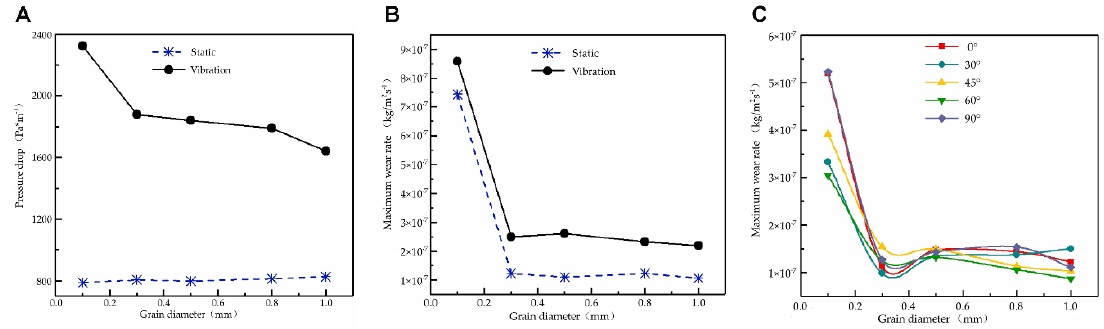
Figure 9. The effect of particle diameter on pressure drop ( A ) and maximum wear rate ( B , C ) at different cross-sections.